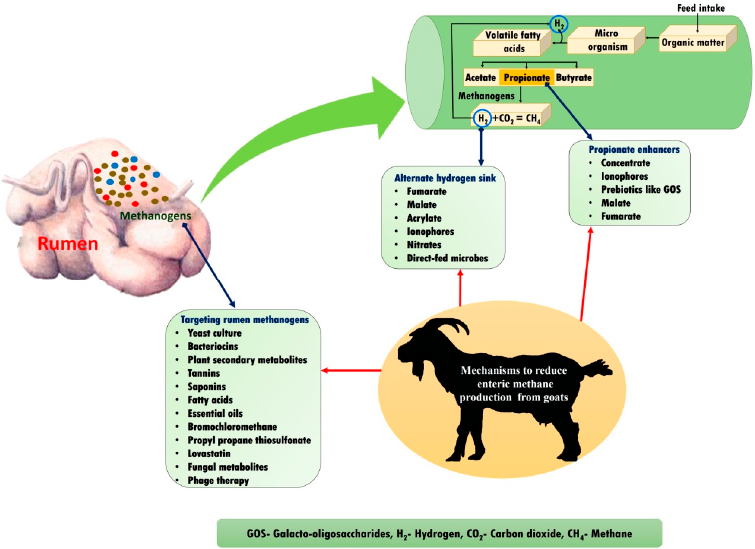
Figure 3. Various mechanisms to reduce enteric methane emission in goats.